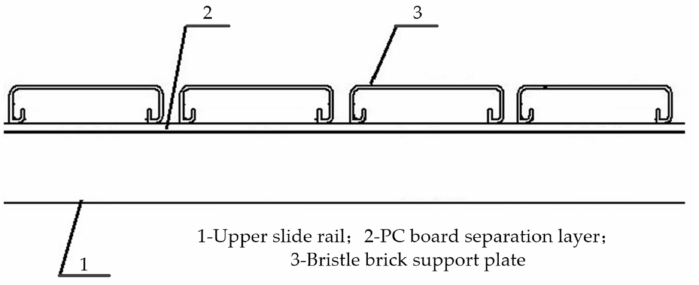
Figure 10. Components of delivery